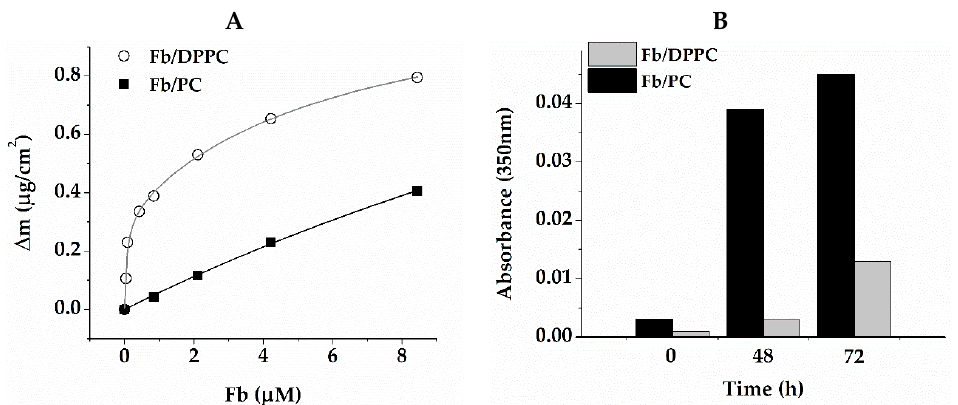
Figure 3. Mass of Fb adsorbed on lipid bilayer at increasing Fb concentration ( A ) and kinetics of lipid release during washing of fibrin–lipid gels ( B ). Data on ( A ) were approximated by two-stage binding kinetics: y = Bmax1 × x/(k1 + x) + Bmax2 × x/(k2 + x). The corresponding rate constants were: k1 = 0.063 ± 0.025, k2 = 6.34 ± 1.56 for DPPC and k1 = 0, k2 = 36.8 ± 8.6 for PC. PC—egg phosphocholine.